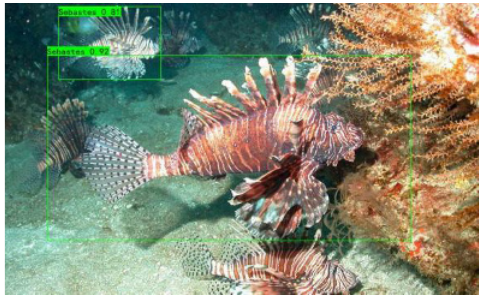
Fig. 13. YOLOX The addition of the ECA module and combining the detection results of ESRGAN.